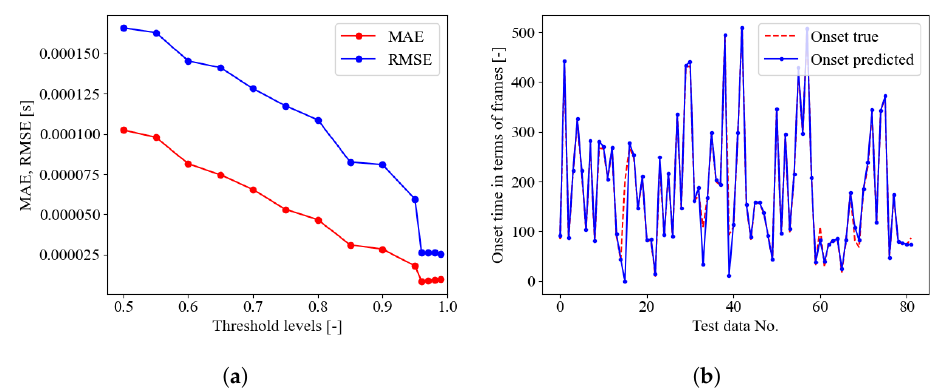
Figure 5. On the left : SED trained on seismic data only, training loss convergence curves. On the right : ROC curve for seismic test set.